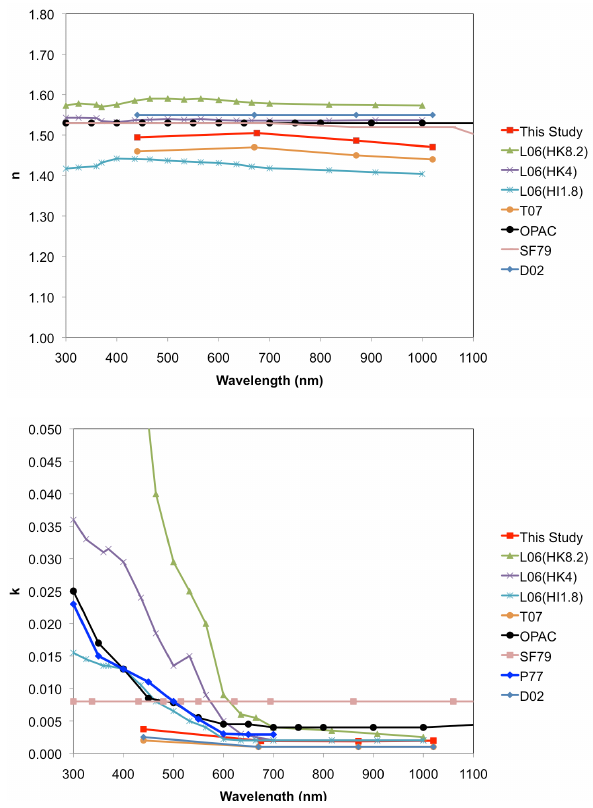
Fig. 5. Real and imaginary refractive index of the dust determined from AERONET (DU) from the current study. T07 is from Todd et al. (2007), OPAC is from Hess et al. (1998), SF79 is from Shettle and Fenn (1979), L06 is from Lafon et al. (2006), and D02 is the Bahrain site (most abosrobing site) in Dubovik et al. (2002). Dif- ferent volume fractions (%) of iron oxide in the hematite-kaolinite (HK) and hematite-illite (HI) aggregates are shown in the parenthe- sis of